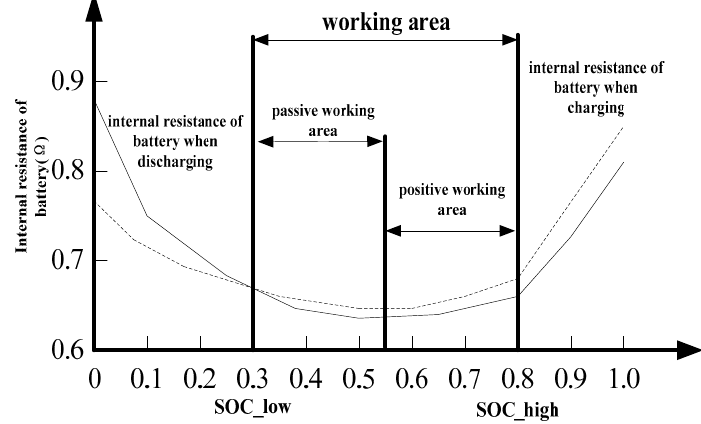
Figure 11. Working area division for nickel-metal hydride battery pack.